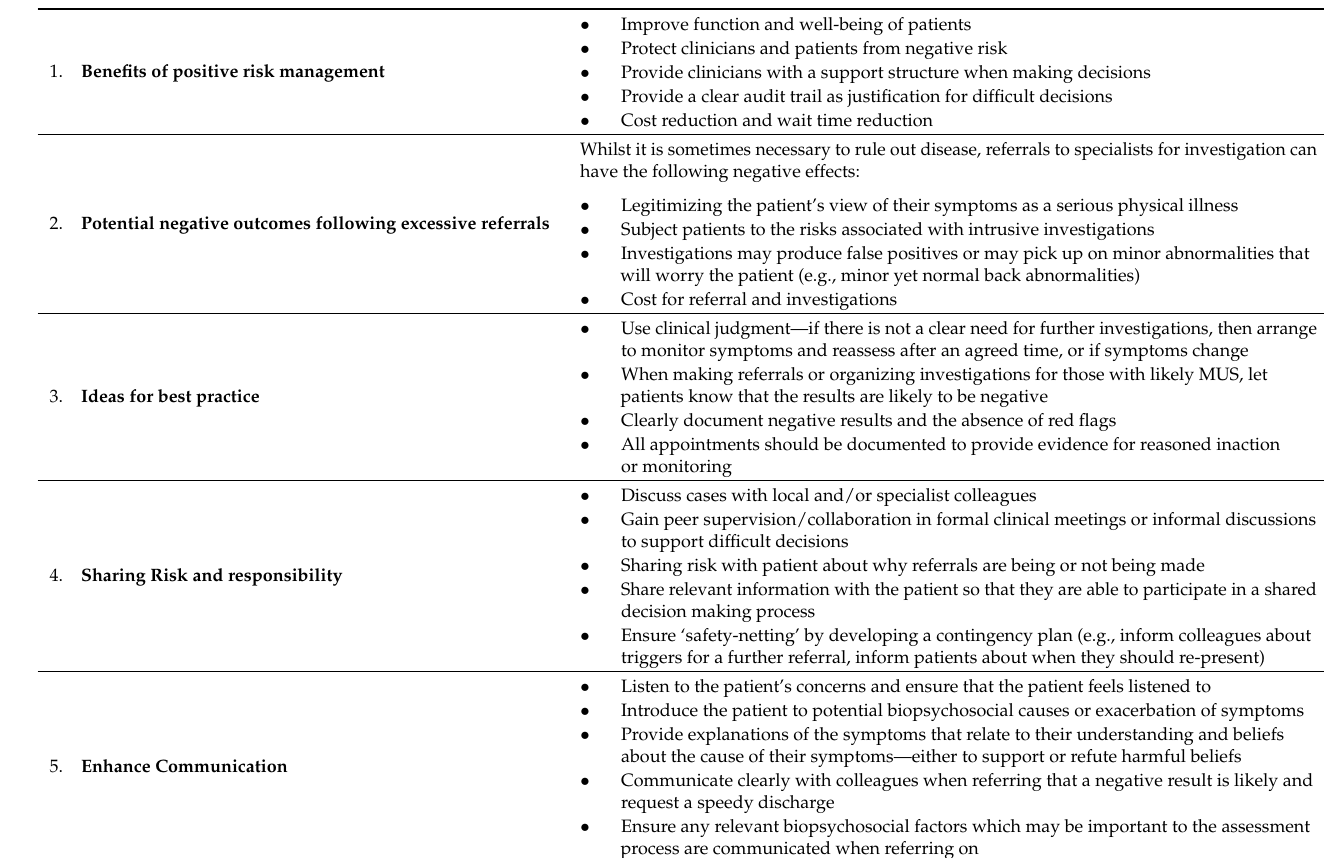
Table 3. Supporting Positive Risk Management